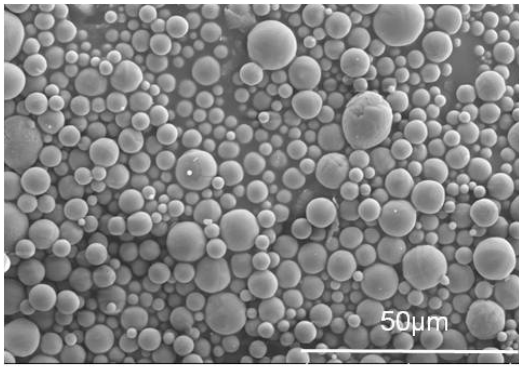
Figure 1. SEM images of pristine Al 2 O 3 .